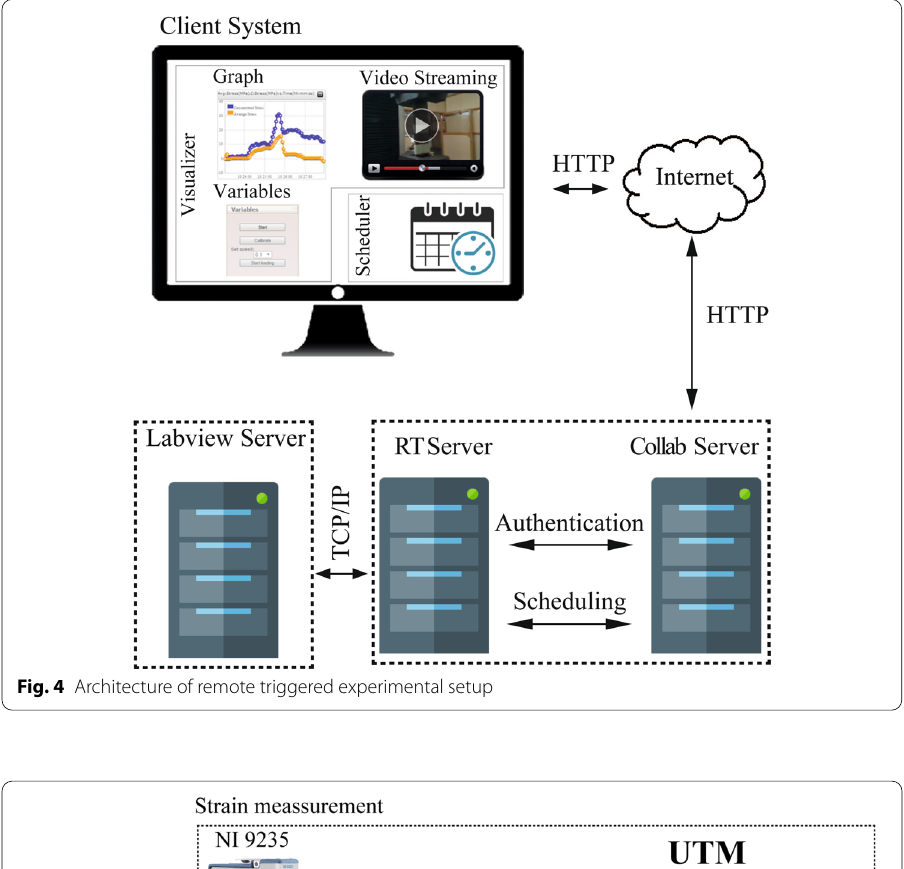
Fig. 4 Architecture of remote triggered experimental setup